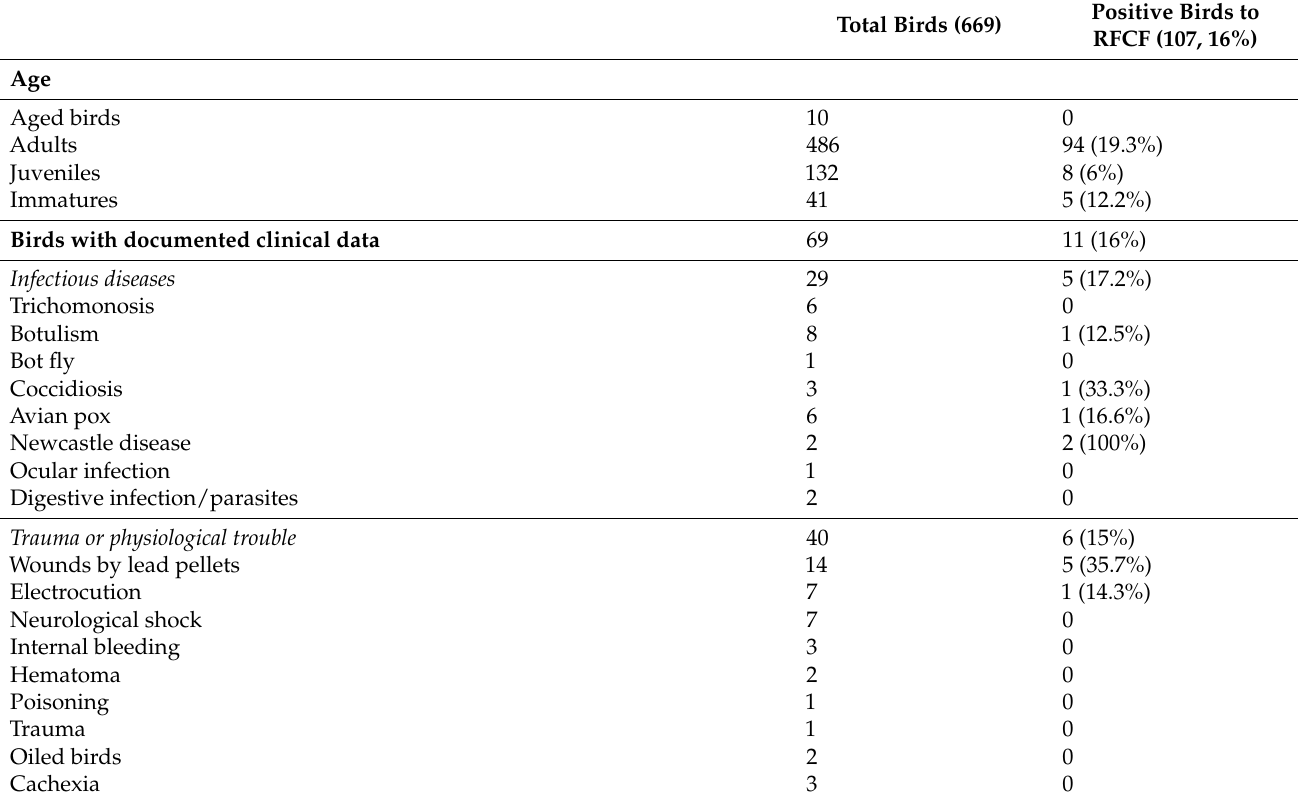
Table 3. General data (age distribution, documented clinical and medication data) about the sampled bird